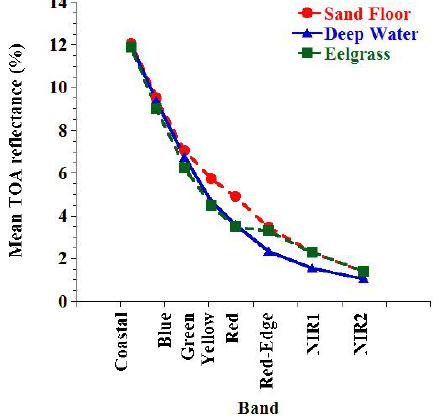
Figure 2. Mean TOA reflectance for each class as a function of the WV-2 band.